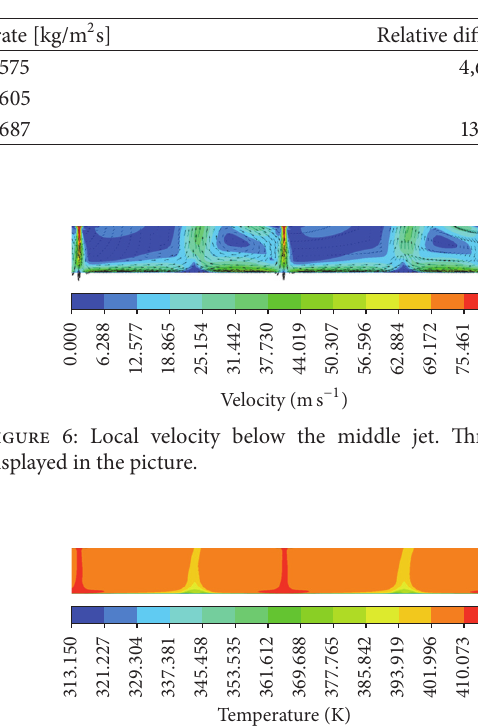
Figure 7: Local temperature below the middle jet. Three jets are displayed in the